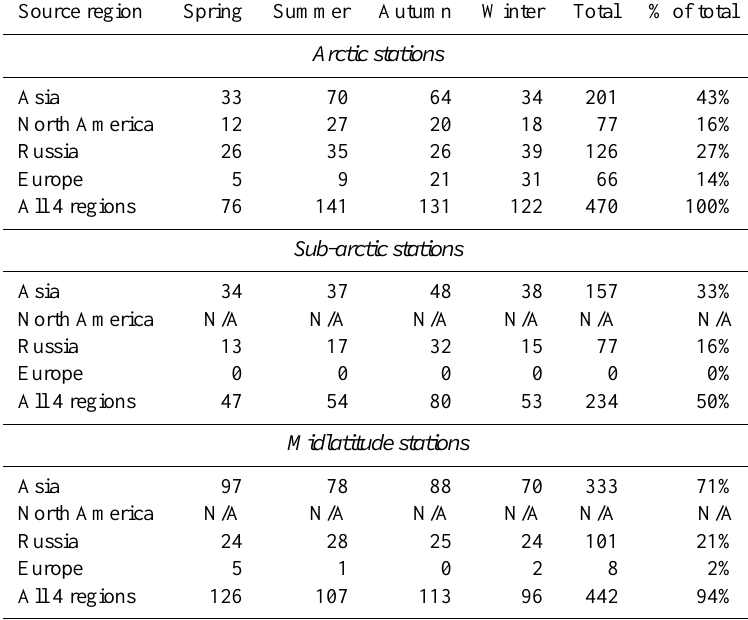
Table 2. Distribution of LRT events by